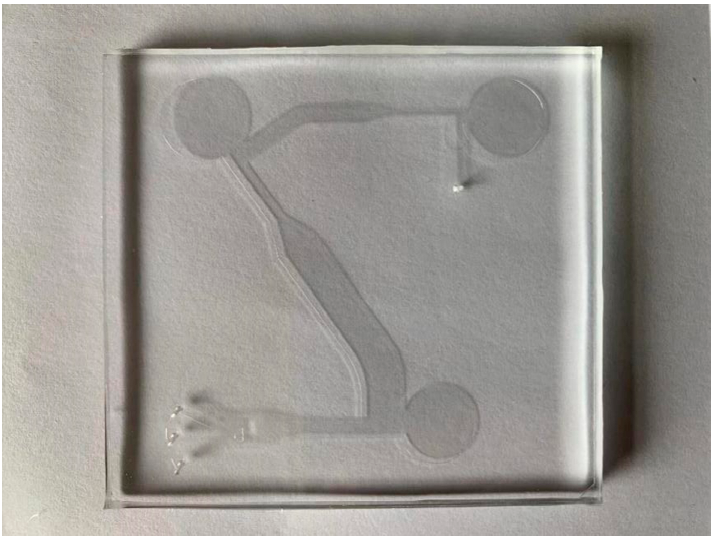
Figure 5. Microfluidic chip.